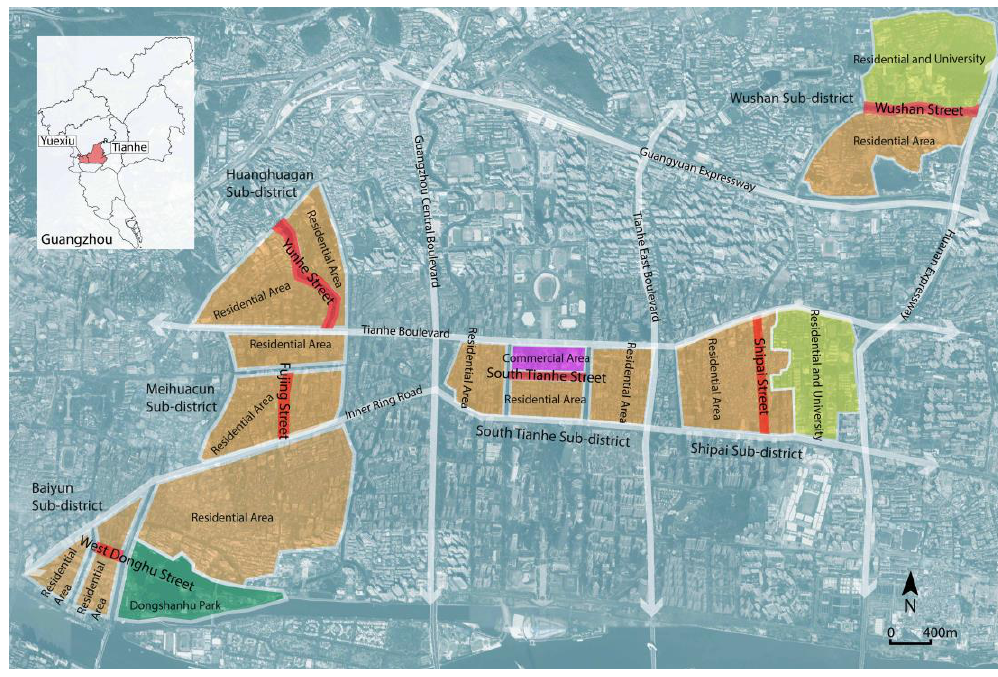
Figure 2. Location of six streets in Guangzhou.